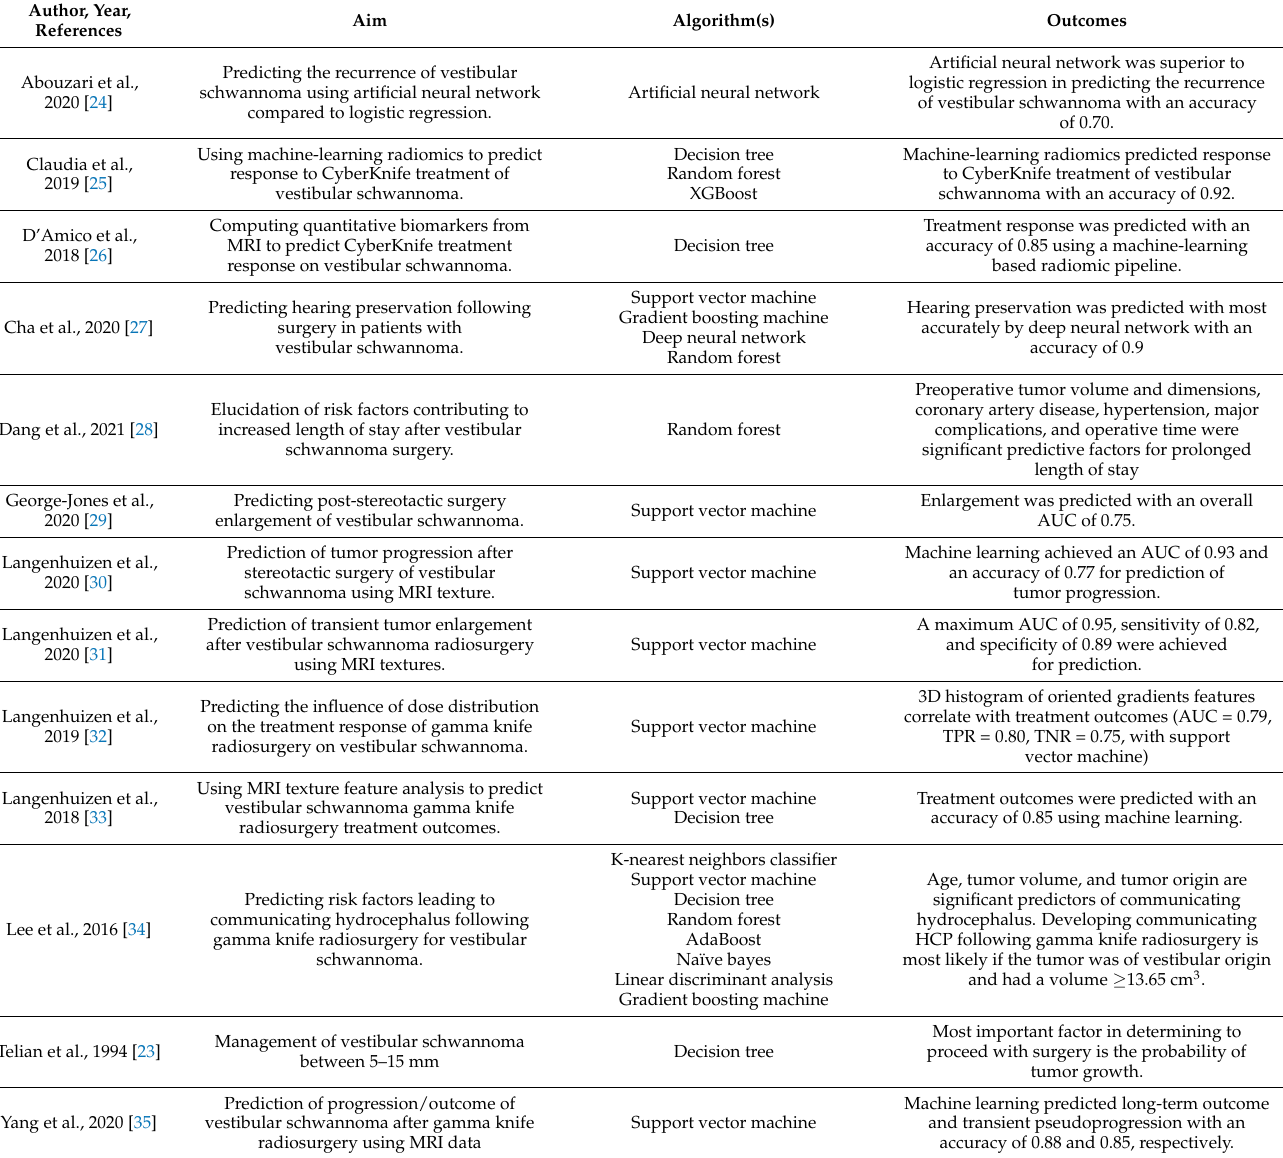
Table 1. Summary of manuscripts with machine learning applications for surgical